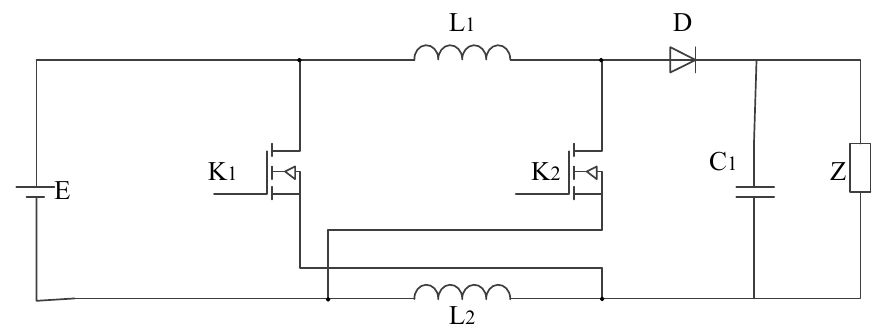
Figure 1. Dual-switch boost converter topology.